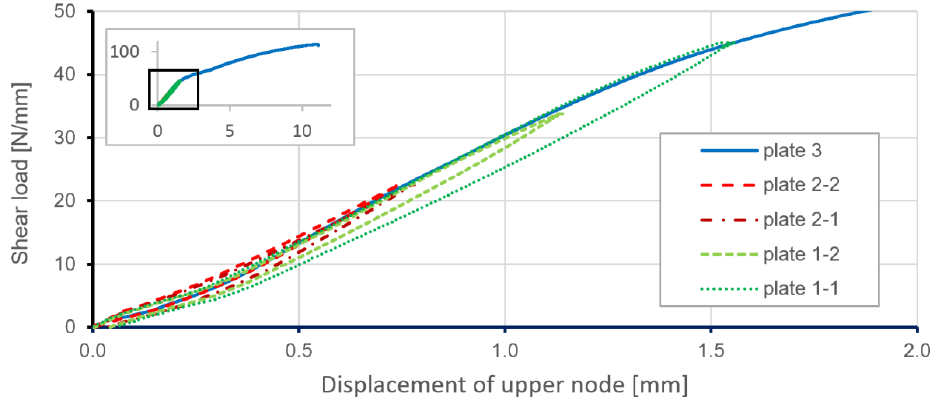
Figure 4. Experimental setup: ( a ) loading conditions, ( b ) plate mounted in the test area of the strength machine.